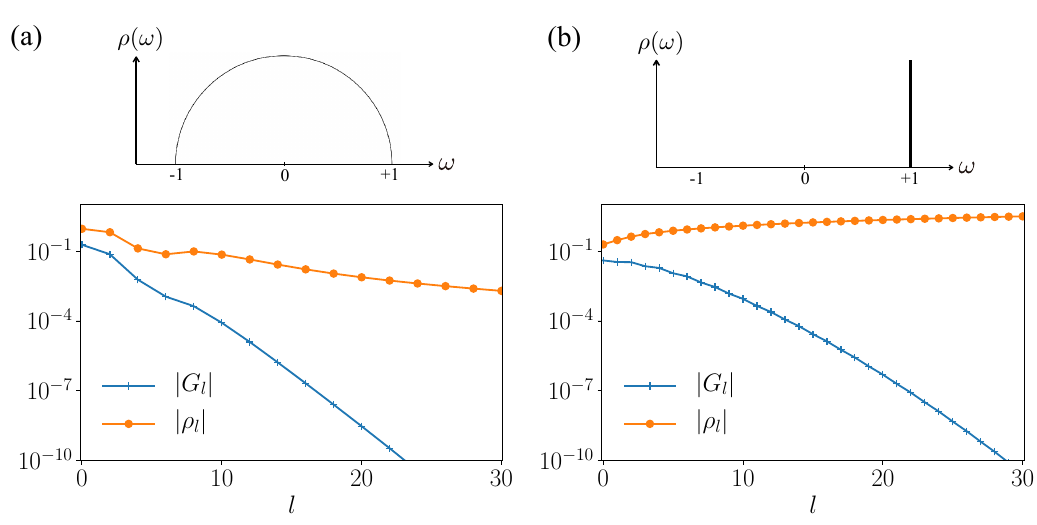
Figure 2: IR expansion coefficients G for (a) a semicircular spectral function and (b) a delta function. We take β = 100, ω = 1, and α = F. In (a), G max values of